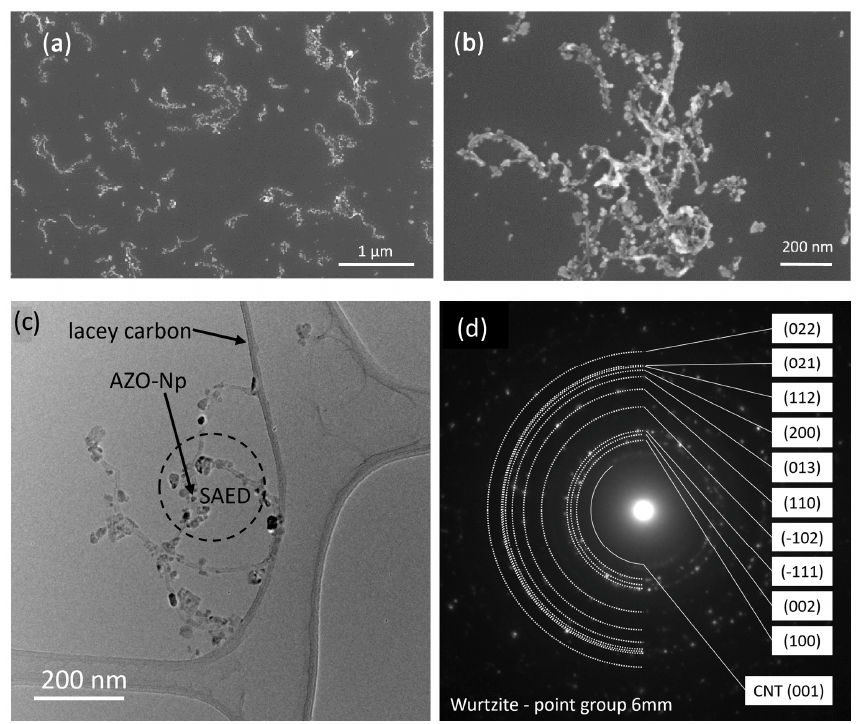
Figure 2. Lower ( a ) and higher ( b ) magnification SEM images of AZO-decorated CNTs, with an AZO:CNT weight ratio of 4.2; ( c ) TEM bright field image of AZO-decorated CNTs; ( d ) SAED pattern of the region indicated in ( c ).